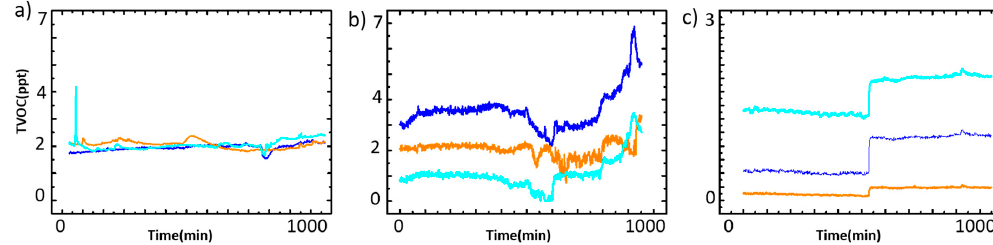
Figure 4. Raw data from the TVOC sensor groups: ( a ) CONSTANT situation, ( b ) EVENT 1: increasing TVOC rate at 1.45 ppt / min, ( c ) EVENT 2: increasing TVOC rate at 10.02 ppt / min. Each line color indicates each sensor.